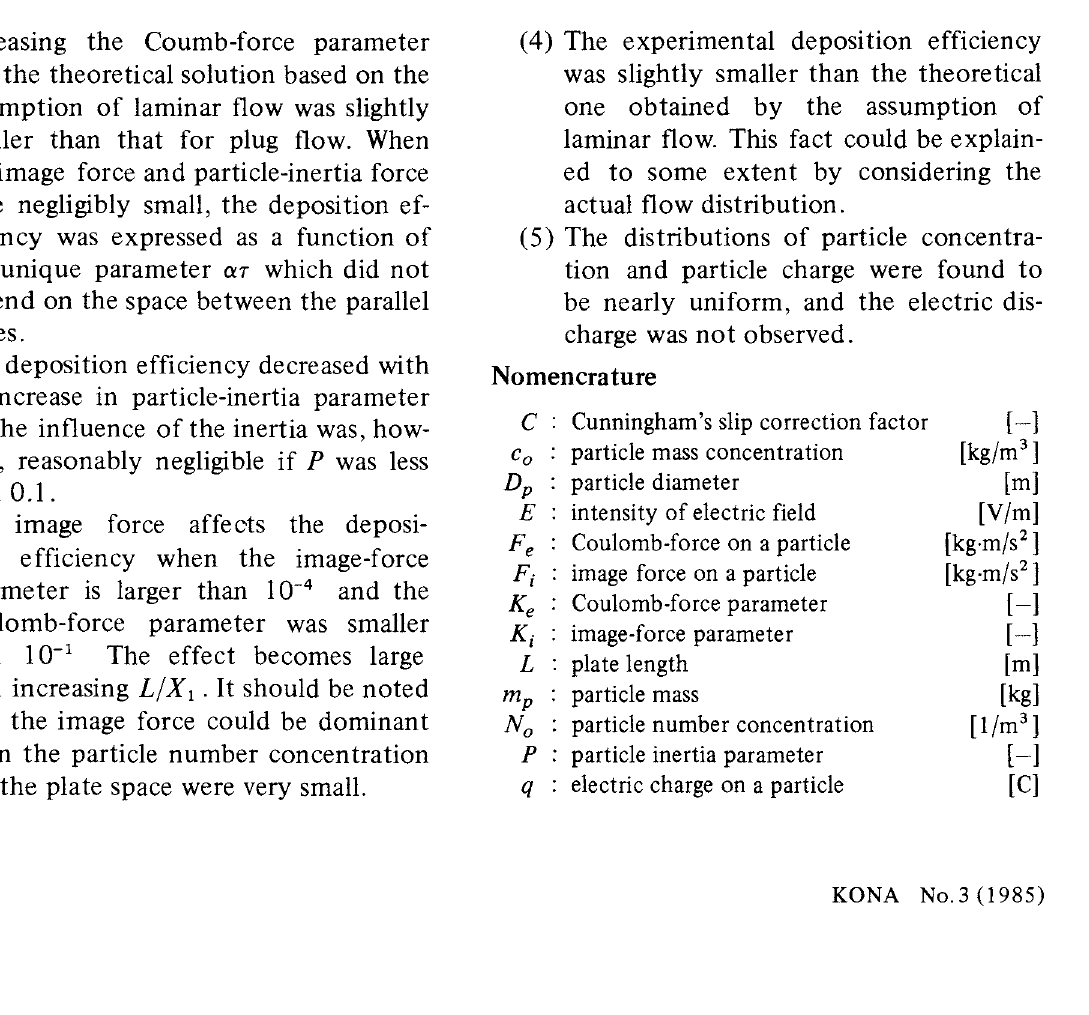
Fig. 11 Experimental distributions of the particle concentration (at the inlet of test